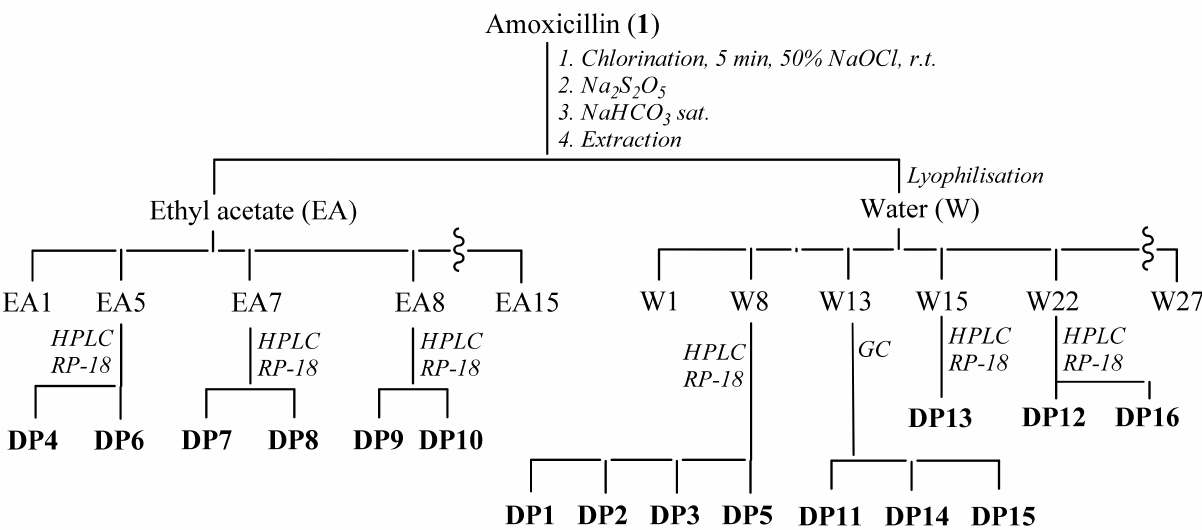
Scheme 1. Isolation of 16 identified degradation